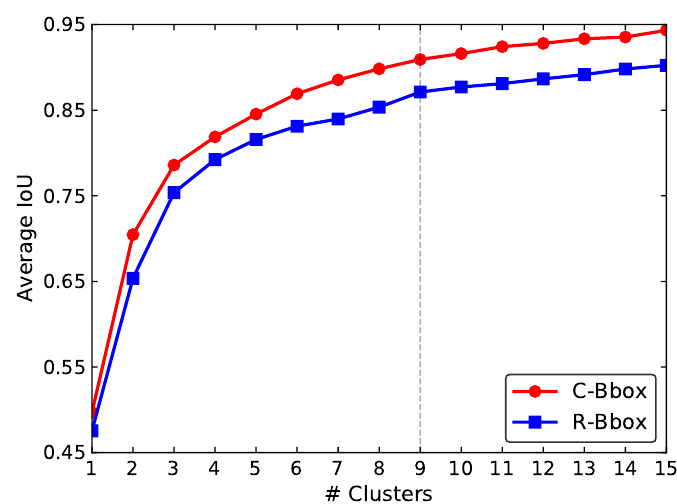
Figure 10. Clustering anchor dimensions of R-Bbox and C-Bbox. The k-means clustering was used to get the prior anchors. As in [24], the IoU was adopted instead of the Euclidean distance as the evaluation metric. As indicated by the dotted vertical line, nine clusters were adopted as the prior anchors, and were then divided into three parts and assigned to each of the three scales for detection.